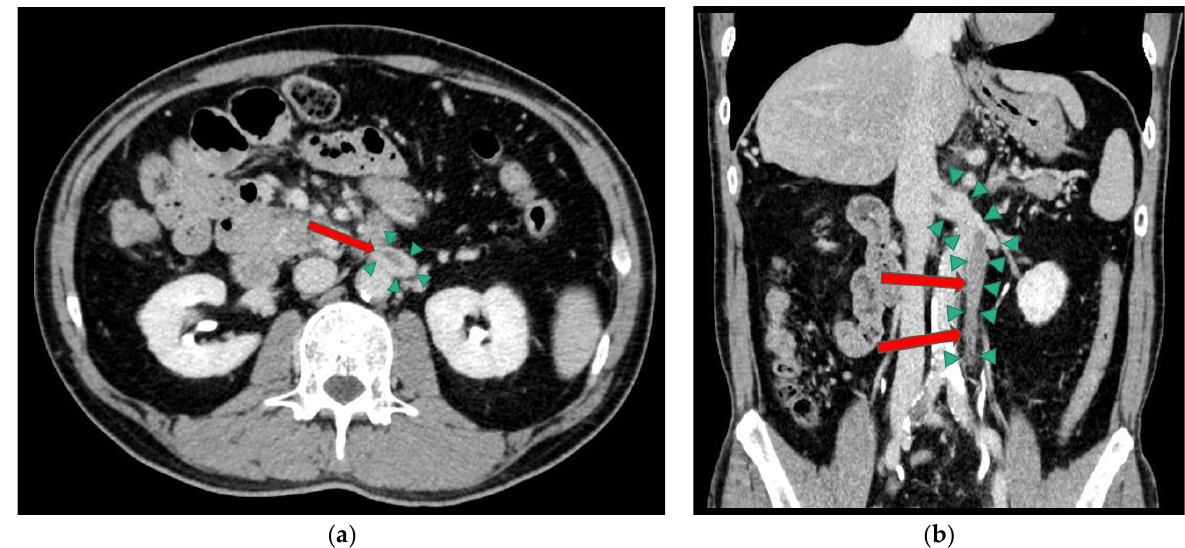
Figure 4. Abdominal contrast-enhanced computed tomography scan. Thrombi in the duplication of the inferior vena cava (IVC), left common iliac vein, left IVC, and left renal vein. ( a ) Axial view. ( b ) Coronal view. thrombus. duplication of the IVC.